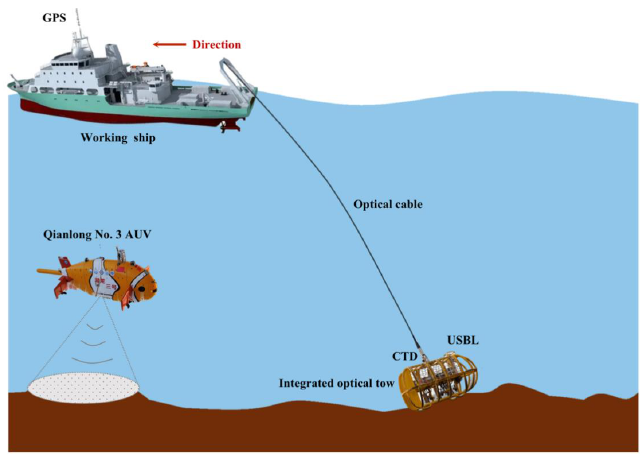
Figure 2. Working principle.